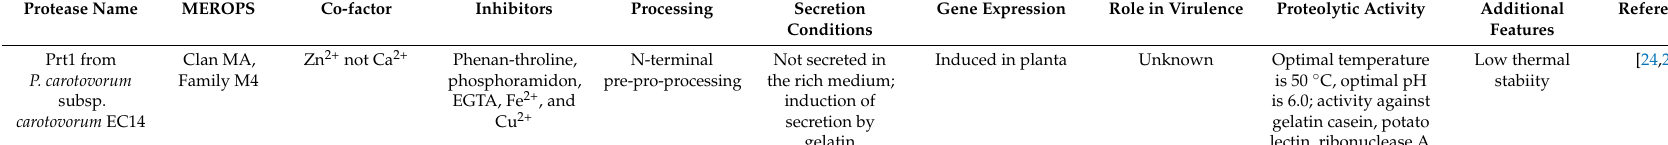
Table 2. Characteristic of selected extracellular